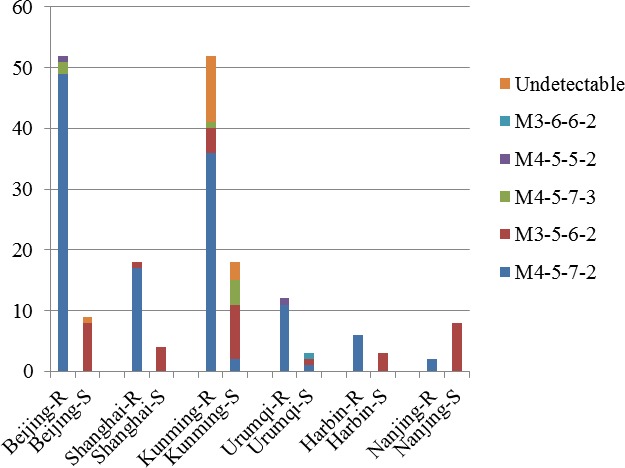
Different genotypes observed in macrolide-resistant and macrolide-sensitive specimens obtained from different sites in China.R, resistant; S, sensitive; Undetectable, the repeat number of the four loci could not be fully determined because of low DNA concentration.